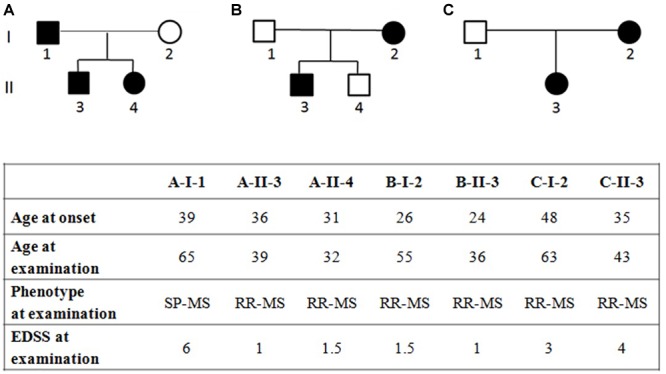
Pedigree of families (A–C) with multiple sclerosis and clinical characteristics of the affected family members, RR-MS, relapsing-remitting multiple sclerosis; SP-MS, secondary-progressive multiple sclerosis; PP-MS, primary progressive multiple sclerosis; EDSS, expanded disability status scale. EDSS ranges from 0 to 10 in 0.5-point increments; higher scores indicate more disability.